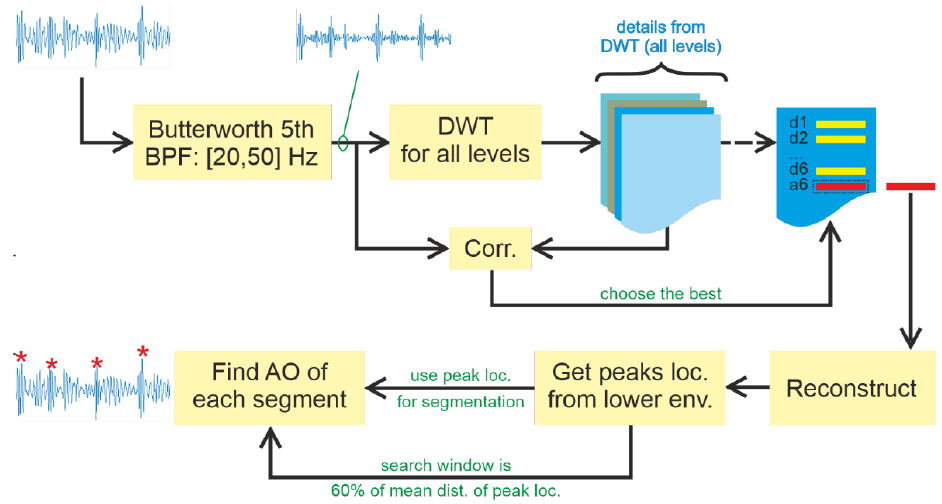
Figure 4. Both signal enhancement and Algorithm #1 are presented as a block diagram. The asterisks in the figure represent the detected AO from the algorithm.